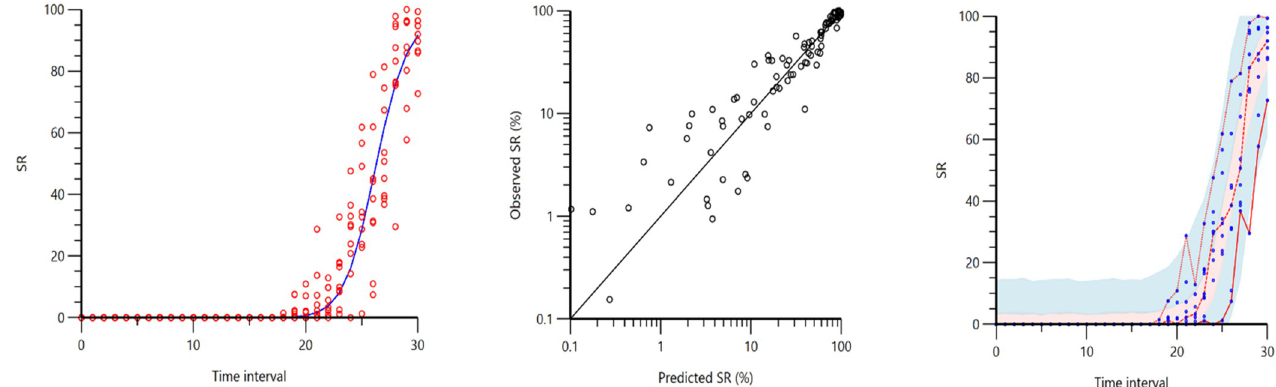
Fig 3. Pharmacodynamic modeling of suppression ratio (SR). A. Observed data (circles) and prediction from the final population model (line) for SR during increasing propofol infusion rate. The time axis shows the normalized time intervals. B. Observed SR data against individual-predicted values. C. Prediction- corrected visual predictive check (for 1000 simulations) of the final model for SR; Blue dots = observations; red lines = 5 th , 50 th , and 95 th percentiles of the observed values; red/blue shaded area = 95% CI of the 5 th , 50 th and 95 th percentiles of the final prediction model.